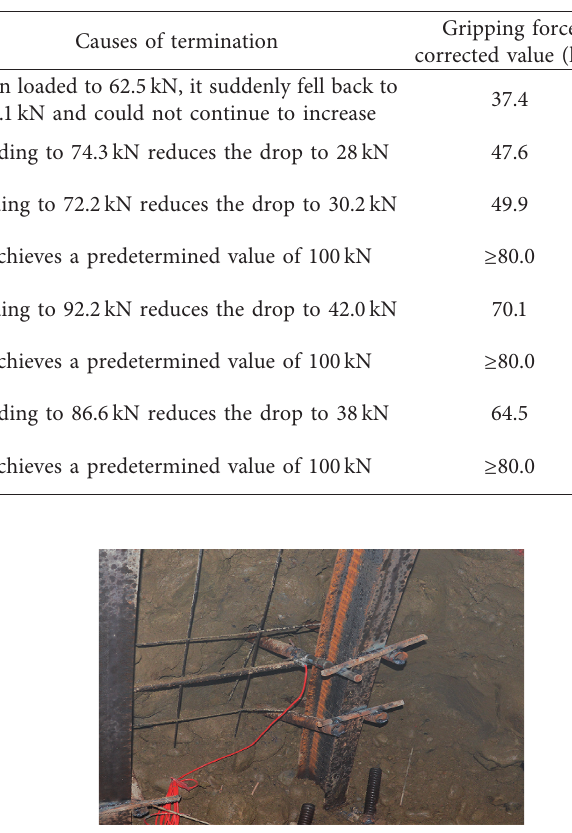
Figure 25: Installation site of feet reinforcement bolt axonometric- apparatus.